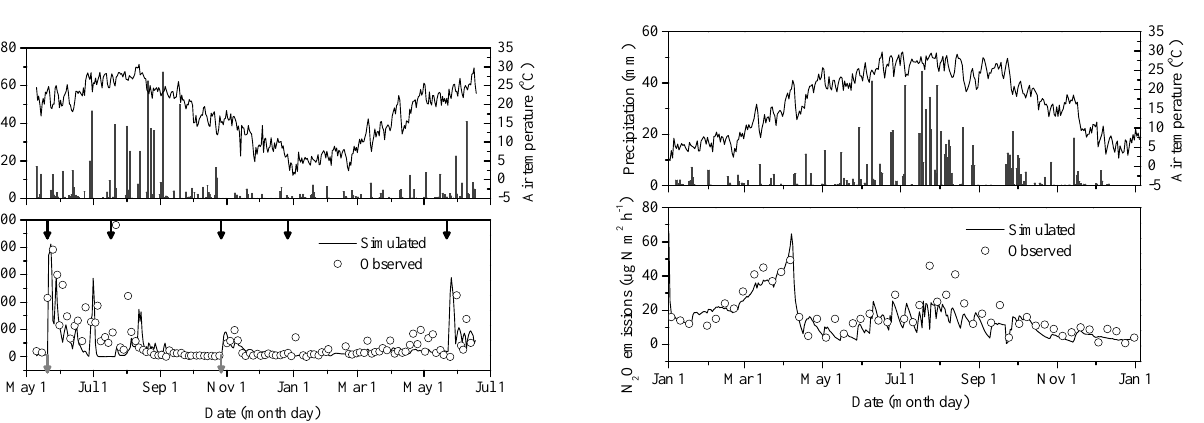
Fig. 5. Precipitation and air temperature (a) , simulated and ob- served nitrous oxide emissions (b) from typical cropland planted with maize and winter wheat in the Yanting watershed during the rotational year of 2004–2005. The gray and black arrows indicate the dates of tillage and fertilization, respectively.